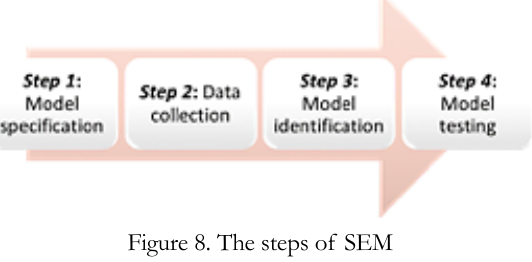
Figure 8. The steps of